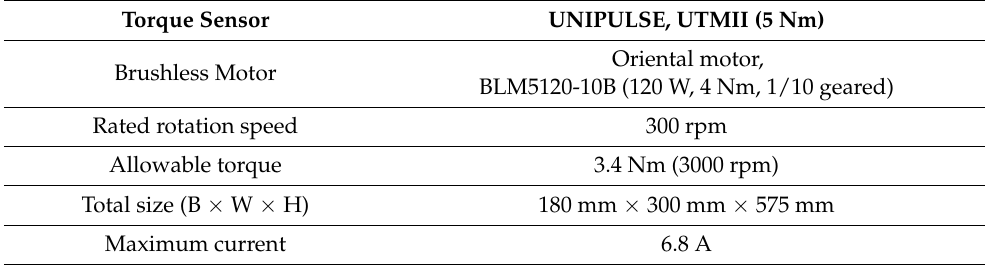
Table 1. Specifications of the durability testing machine.